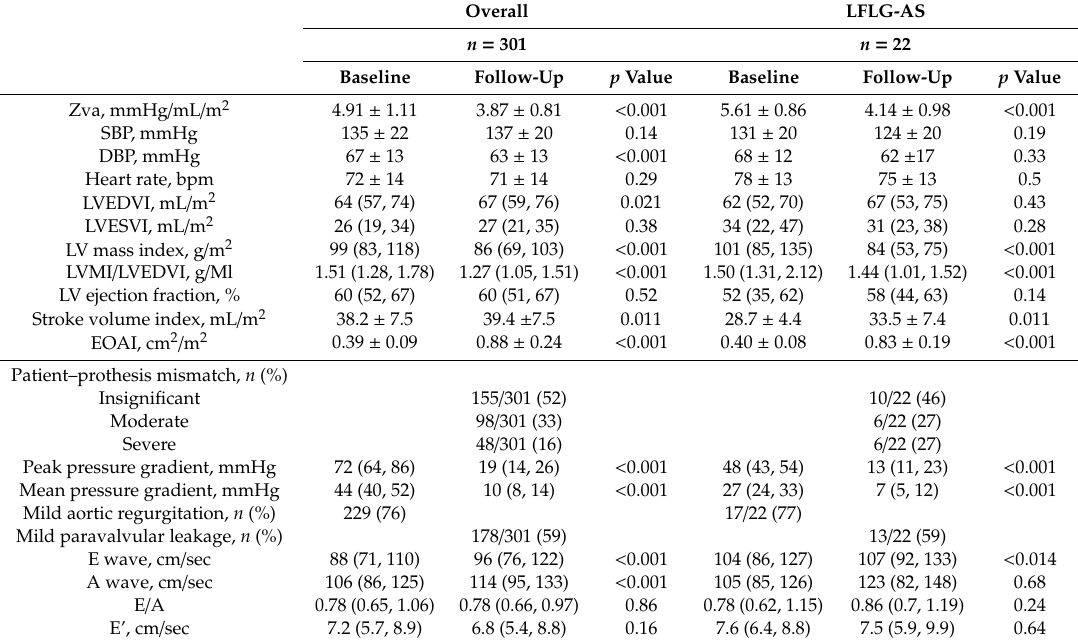
Table 2. Valvuloarterial impedance, hemodynamics, and echocardiographic parameters before and after transcatheter aortic valve